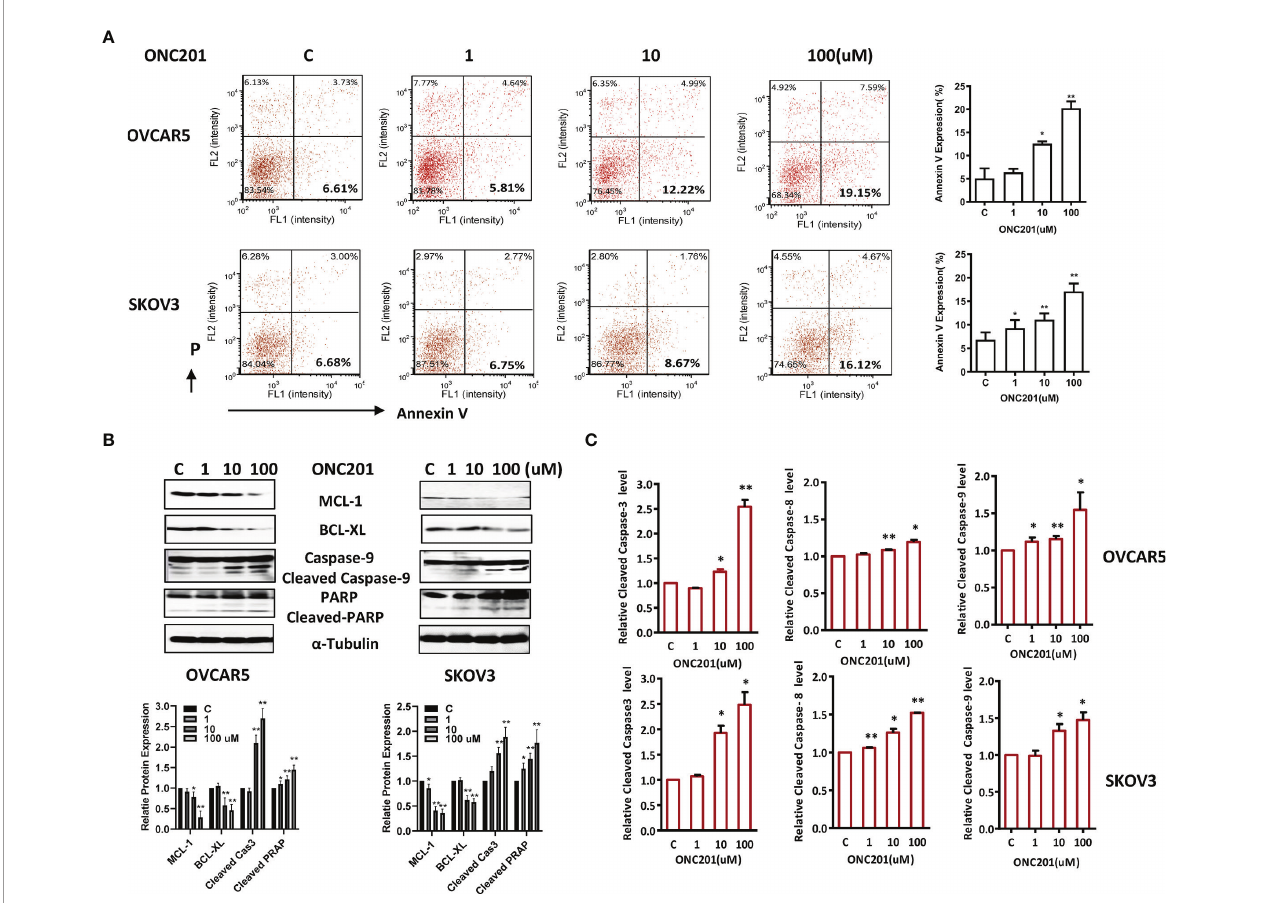
FIGURE 3 | ONC201 induced apoptosis in OC cells. OVCAR5 and SKOV3 cells were incubated for 30 hours with the indicated amount of ONC201. Annexin V was analyzed by Cellometer (A) . Total cell lysates were prepared and analyzed by western blotting for MCL-1, BCL-XL, Cleaved caspase 9 and PARP (B) . Cleaved caspase 3, 8 and 9 activity was assayed by ELISA assay. ONC201 induced the activity of the cleaved caspases 3, 8 and 9 in both cell lines after treatment with ONC201 or the vehicle controls for 8-12 hours (C) . The results are shown as the mean ± SD and are representative of three independent experiments. *p < 0.05, **p <